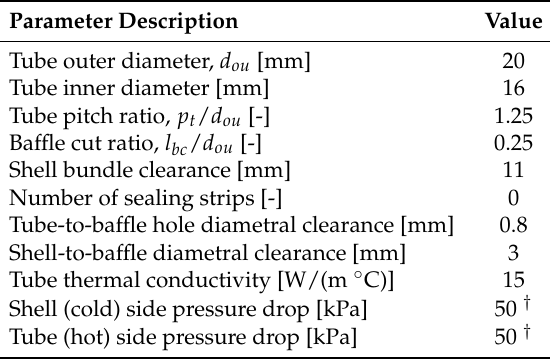
Table 3. Condenser modeling